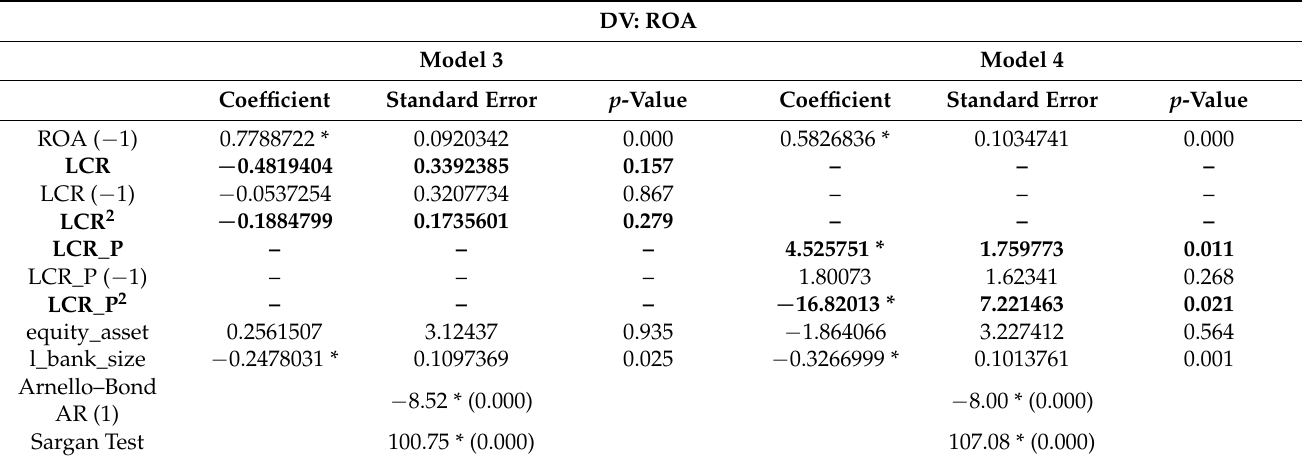
Table 5. Dynamic Panel Data Model (Models 3 and